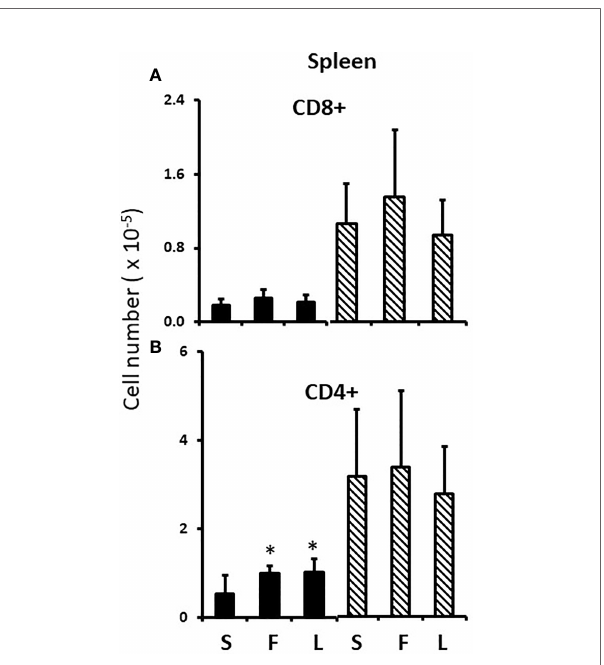
FIGURE 7 | Effect of fl utamide and letrozole on numbers of cells in the pup spleen. FCG Mouse pups were treated between days 1 and 7 postpartum before collection of spleens. Data are derived from gated lymphocytes, presented as the mean ± SD, and are derived from the same animals as for Figure 5 . S, sesame oil control; F, fl utamide; L, letrozole. Males include both XYM and XXM (solid bars) and females include both XXF and XYF (cross- hatched bars). Different from same sex control *, p< 0.05, effect size